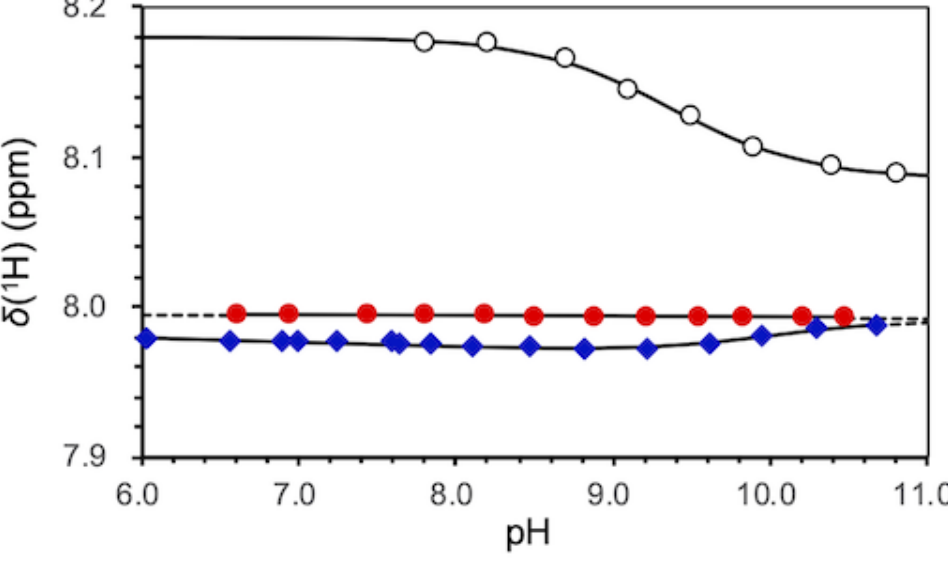
Figure 3. Plot of the chemical shift of H8(G12*) of the model RNA duplex 1 against pH (basic region). Red circle: H8(G12*) chemical shift in the absence of CdCl 2 . Blue diamond: H8(G12*) chemical shift in the presence of CdCl 2 . Open circle: H8( 5′ -GMP) chemical shift in the absence of CdCl 2 . In the respective titration data, their corresponding theoretical curves are indicated. In the theoretical curves for model RNA duplex 1 , extrapolated theoretical curves are presented as broken lines.